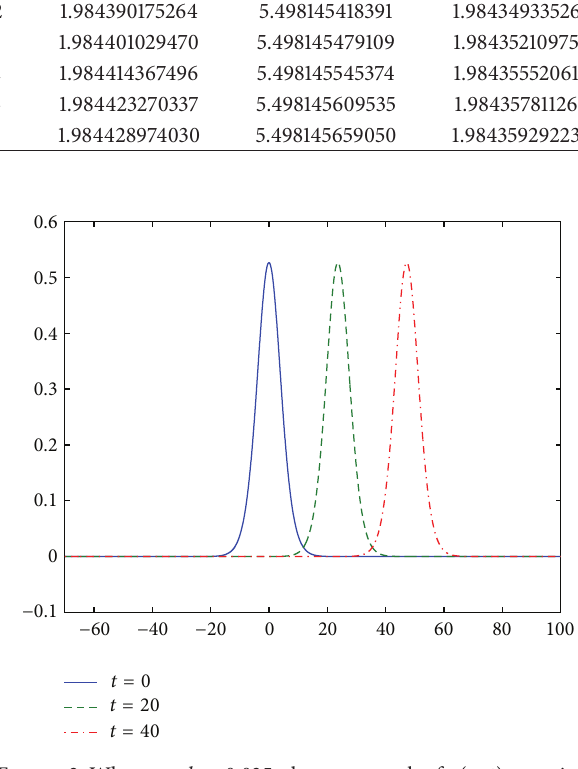
Figure 2: When 𝜏 = ℎ = 0.025 , the wave graph of 𝑢(𝑥,𝑡) at various